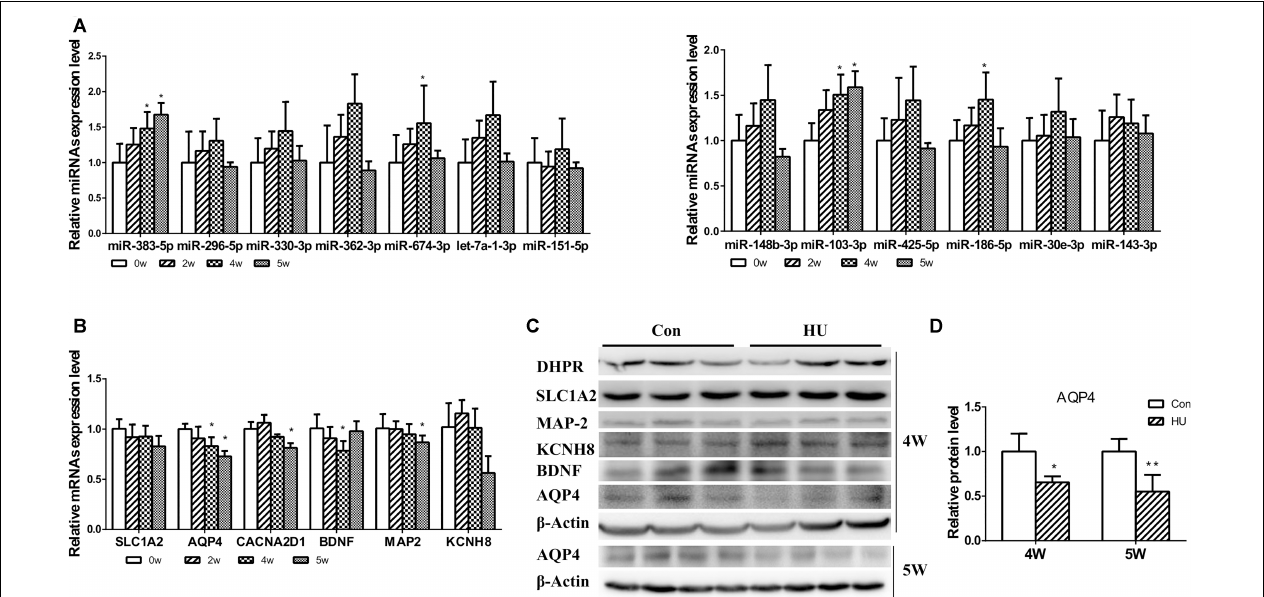
FIGURE 3 | Analysis of differential expression miRNAs and target genes in the hippocampus. (A) 13 upregulated serum miRNAs were detected in the hippocampus after rat HU for 0, 2, 4, and 5 weeks; miR-103-3p and miR-383-5p showed significant upregulation ( n = 5), * p < 0.05. (B) The mRNA expression levels of predicted target genes were detected in the hippocampus after rat HU for 0, 2, 4, and 5 weeks; AQP4 showed significant downregulation ( n = 5), * p < 0.05. (C) The protein expression levels of predicted target genes were detected in the hippocampus after rat HU; AQP4 showed significantly downregulation after rat HU for 4 or 5 weeks ( n = 3), The samples derive from the same experiment and the blots were processed in parallel, * p < 0.05. (D) Relative expression levels of AQP4 were normalized to β -actin ( n = 3), * p <